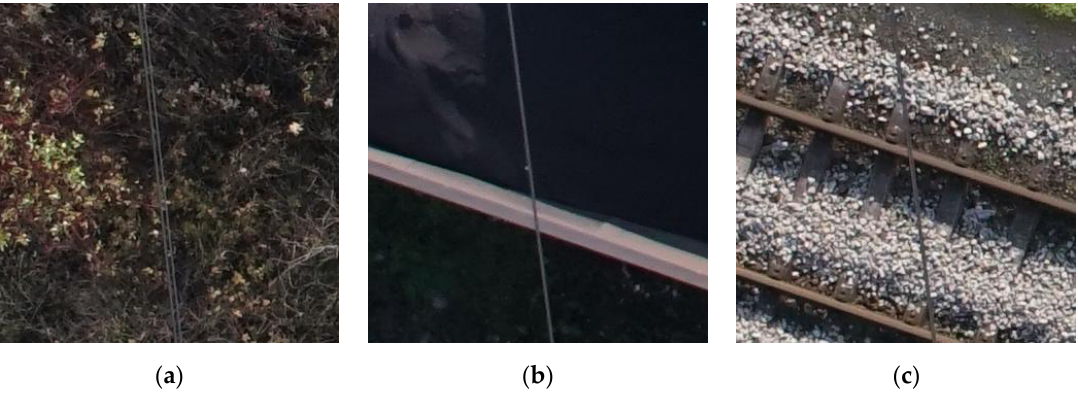
Figure 17. Example problematic images: ( a ) closely recorded wires; ( b , c ), two wires recorded as one line.